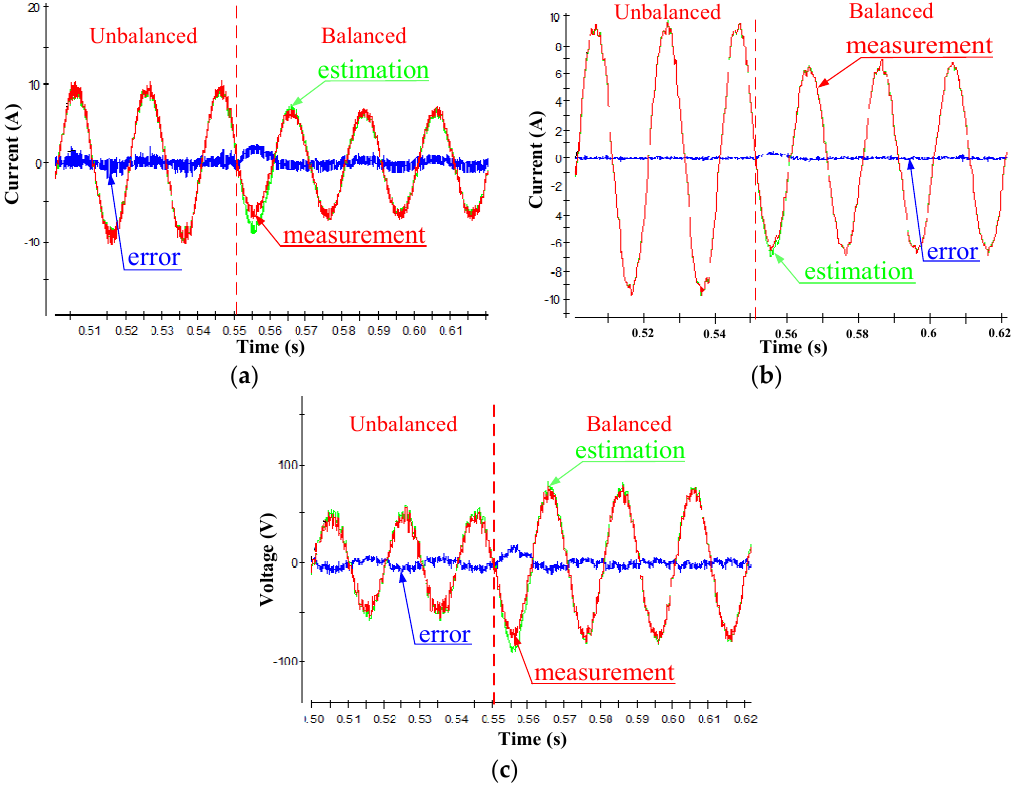
Figure 11. Experimental comparisons between measurements and estimations for the state variables in b-phase when grid voltage varies from unbalanced to balanced in case 1: ( a ) Inverter-side current, ( b ) grid-injected current, ( c ) capacitor voltage.